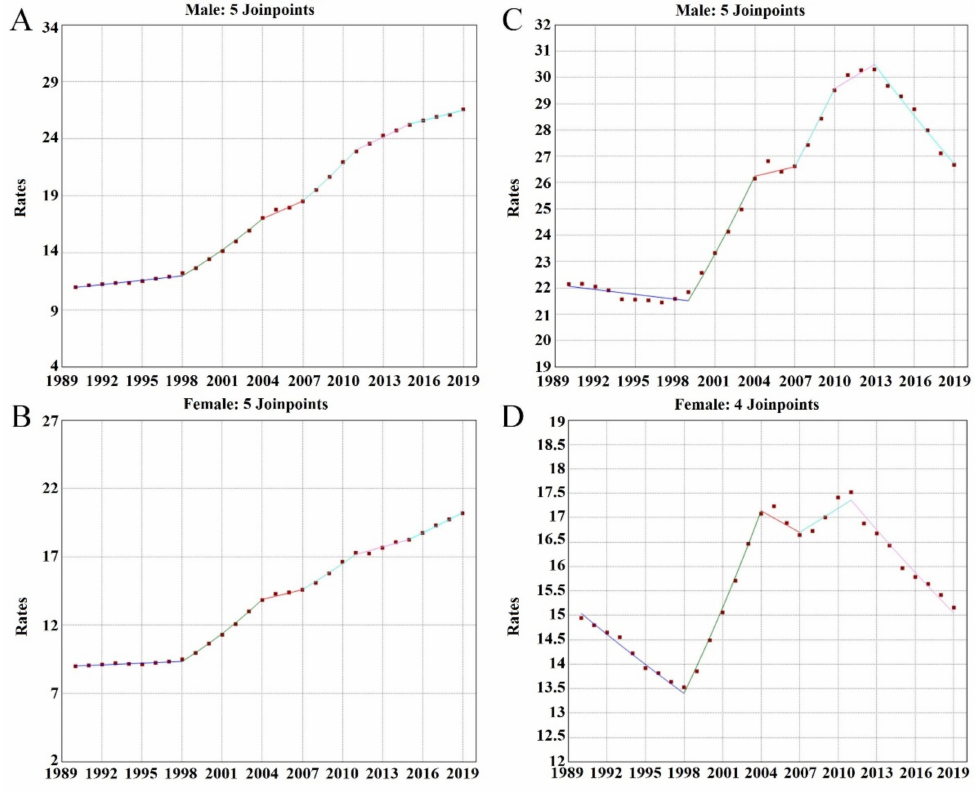
Figure 3. Results obtained from joinpoint analysis. ( A ) Segments of CMR for males; ( B ) segments of CMR for females; ( C ) segments of ASMR for males; ( D ) segments of ASMR for